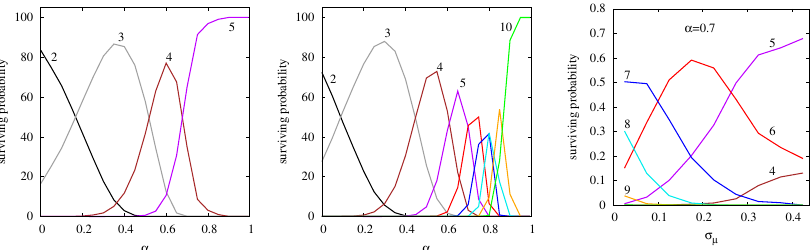
Fig. 6 The left and center panels represent the probability that m ≤ N media outlets will survive in the long run as a function of α . The left panel considers N = 5 and the center panel N = 10. The label by each curve indicates the number of surviving outlets. The right panel represents the probability that m ≤ N outlets will survive in the long run as a function of the standard deviation σ μ of the editorial standards. We consider N = 10 and α = 0 .